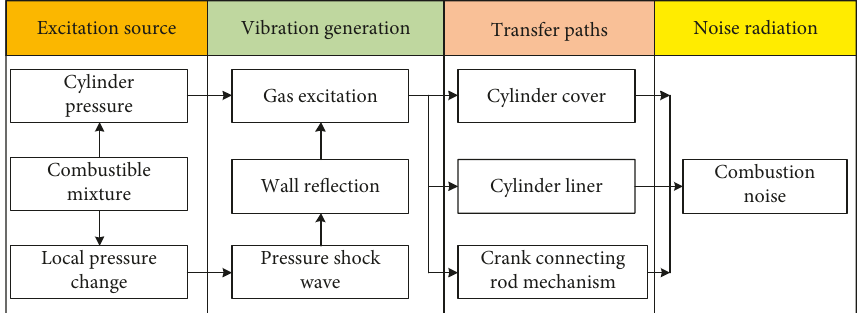
Figure 1: Combustion noise generation and transfer path in an internal combustion engine.